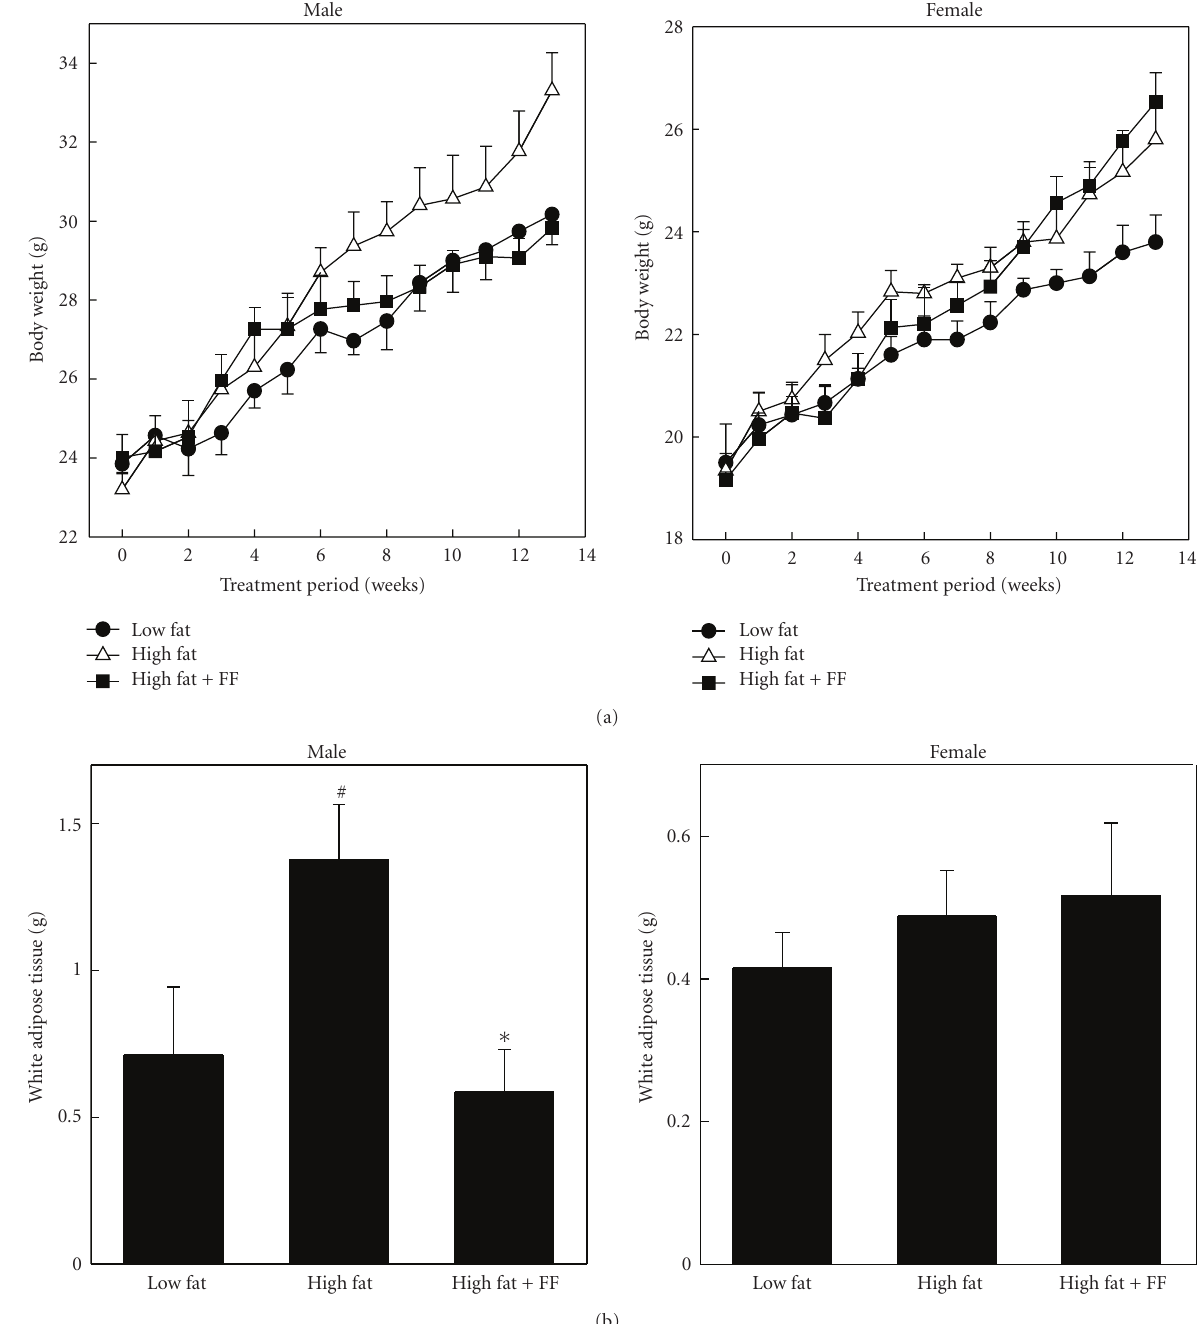
Figure 4: E ff ects of fenofibrate on high fat diet-induced body weight gain (a) and WAT mass (b) in both sexes of C57BL/6 mice. Male and female C57BL/6 mice were received a low fat, high fat, or high fat diet supplemented with fenofibrate (0.05% w/w) for 13 weeks. Body weight at the end of the experiment are statistically di ff erent ( P < . 01) between high fat diet and high fat plus fenofibrate groups. # : Significantly di ff erent versus a low fat diet group, P < . 05 . ∗ : Significantly di ff erent versus a high fat diet group, P < . 01 . Adapted from